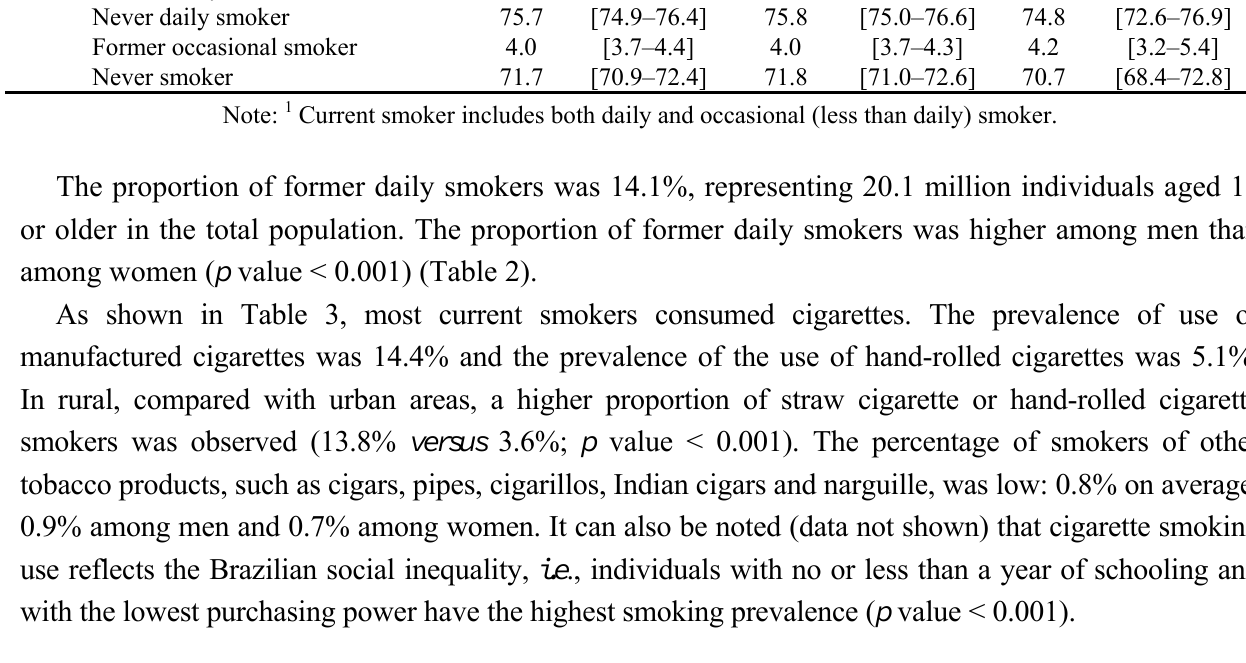
Table 3. Percentage of current tobacco users ≥ 15 years old, by place of residence, gender and tobacco product, GATS Brazil